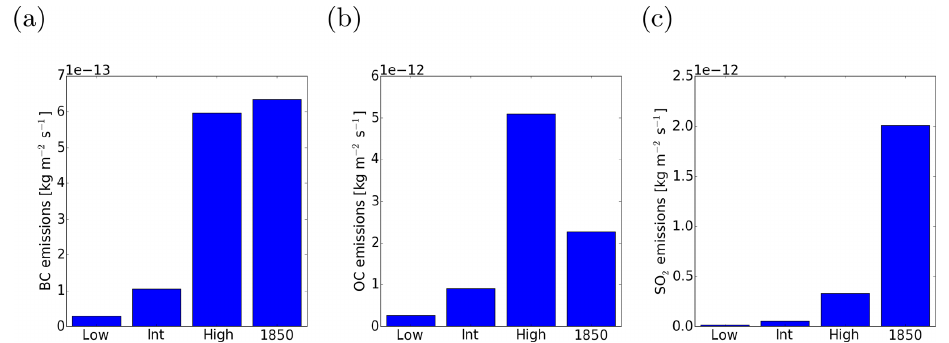
Figure 5. The annual mean anthropogenic aerosol emissions of (a) BC, (b) OC, and (c) SO 2 in 100CE averaged over the study domain (10 ◦ W to 50 ◦ E, 20 to 60 ◦ N) for the low emission scenario (low), the intermediate emission scenario (int), and the high emission scenario (high). Also shown are the anthropogenic aerosol emissions from the ACCMIP inventory for the year 1850CE averaged over the same region.